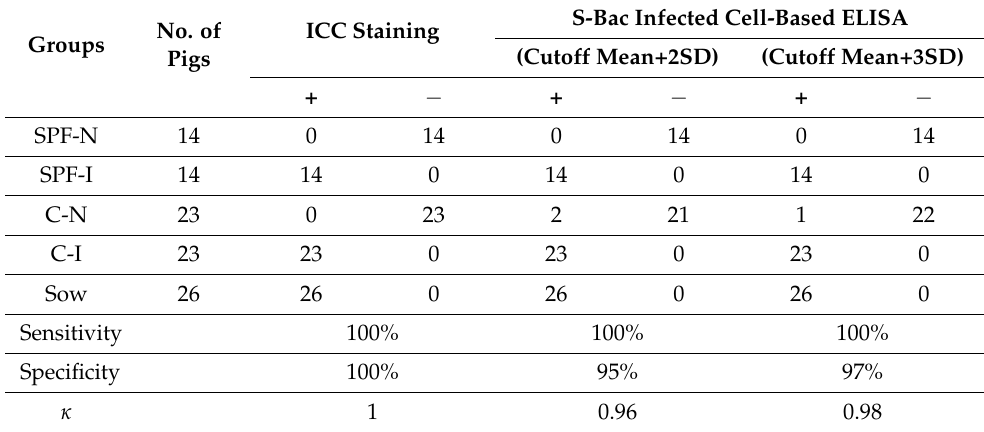
Figure 7. Summary of cell-based ELISA results and ROC analysis. ( A ) Summary of S-Bac-infected cell-based ELISA results for all 100 serum samples in each group in the study. ( B ) ROC curve of S-Bac-infected cell-based ELISA. Sensitivity ( Y -axis) and 1-Specificity ( X -axis) were calculated using the cutoff value 0.1 (mean +3 SD). SPF-N: specific pathogen-free PEDV-negative piglets; SPF-I: PEDV- inoculated SPF piglets; C-N: conventional farm-based PEDV-negative piglets; C-I: PEDV-inoculated conventional piglets; Sow: farm-based sows fed with PEDV-positive intestinal homogenate. Table 1. Statistical analyses of serological results for each